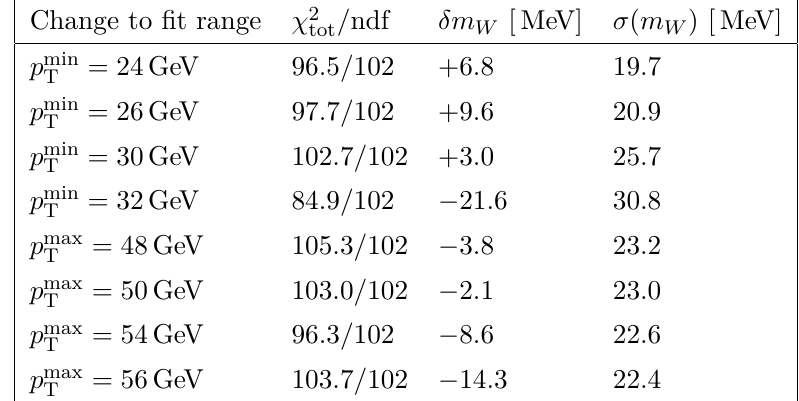
Table 8 . Fit results with variations in the fit range around the default p min 52 GeV. The second column lists the χ 2 values, the third column lists the shifts in m to the default fit and the third column lists the statistical uncertainties in m